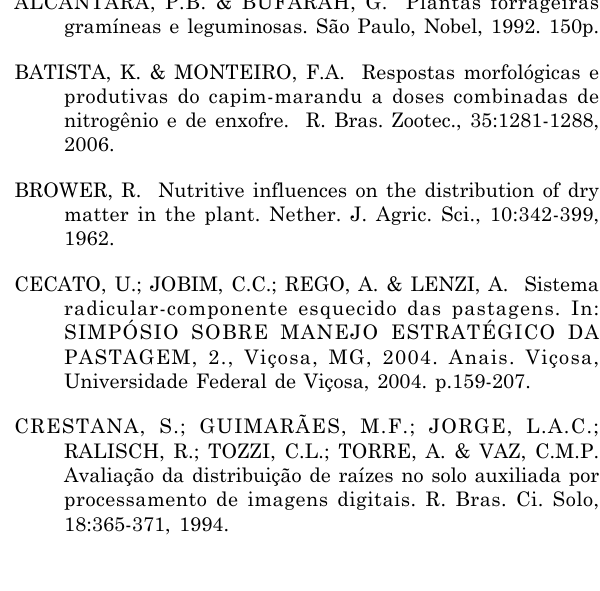
Figura 8. Acúmulo total de enxofre no capim- Marandu, considerando as combinações de doses de nitrogênio e enxofre aos 79 dias do transplantio.